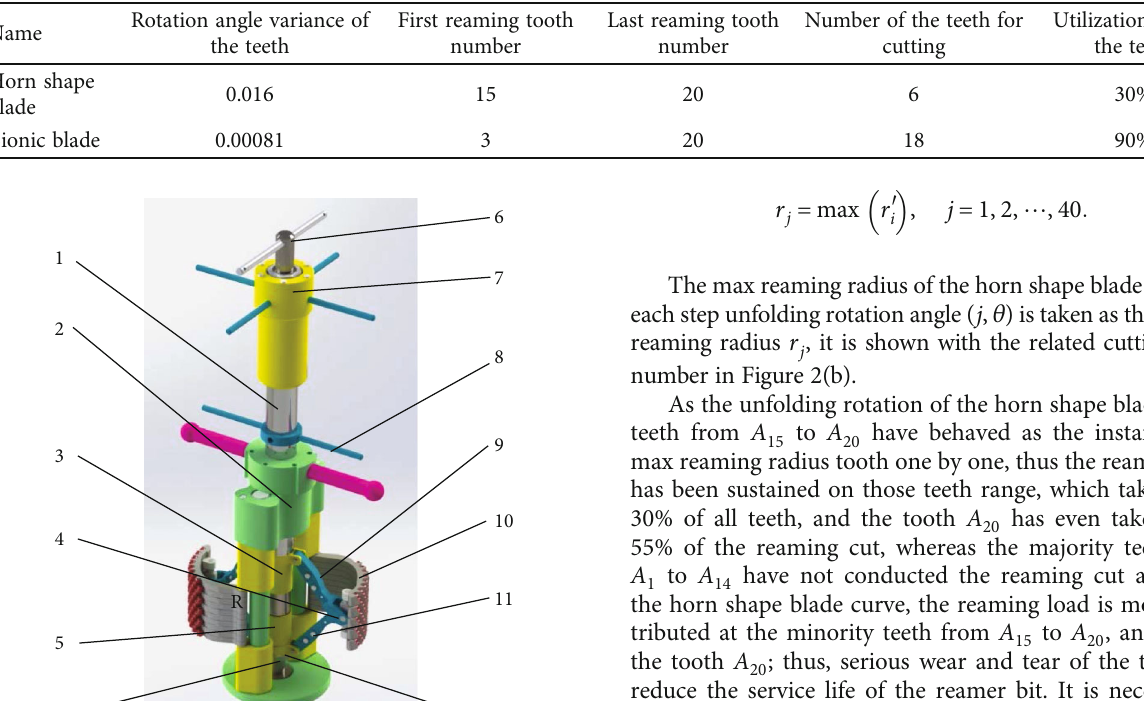
Table 1: Compare of the blades.